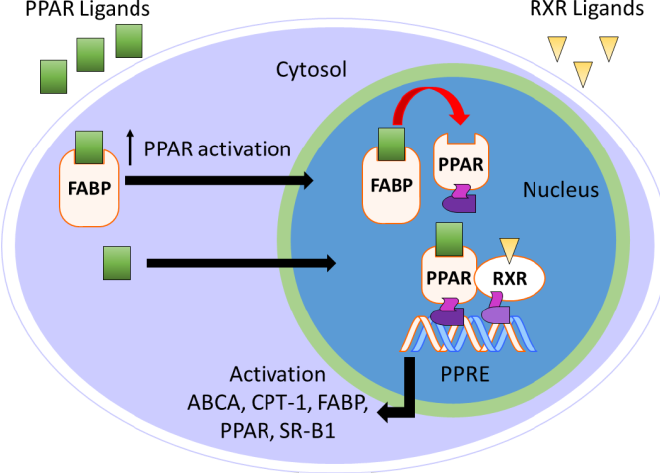
Figure 7. Overview of FABP-mediated PPAR activation.